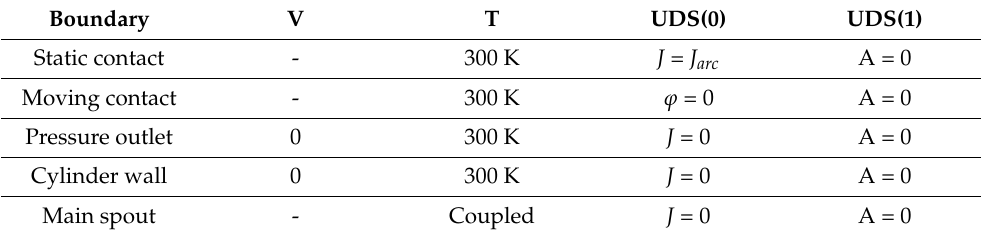
Table 2. Boundary